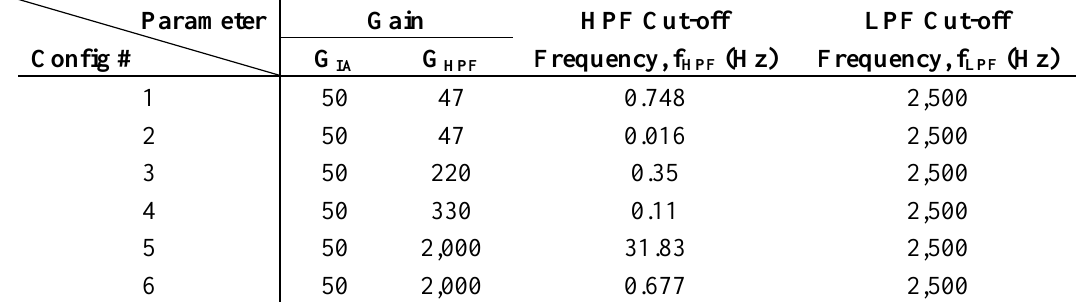
Table 15. Output peak-to-peak noise voltage (mV) at the v